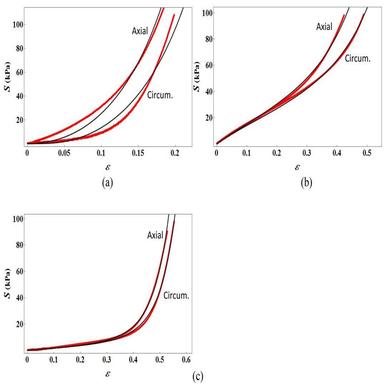
Uniaxial tensile tests on the axial and circumferential strips from intima, media and adventitia from donor IV. 2nd Piola-Kirchhoff stresses versus Green's strains are given. Experimental points in red; fitted material model in black line. (a) Intima, coefficient of determination R2 = 0.969; (b) media, R2 = 0.998; (c) adventitia, R2 = 0.998.